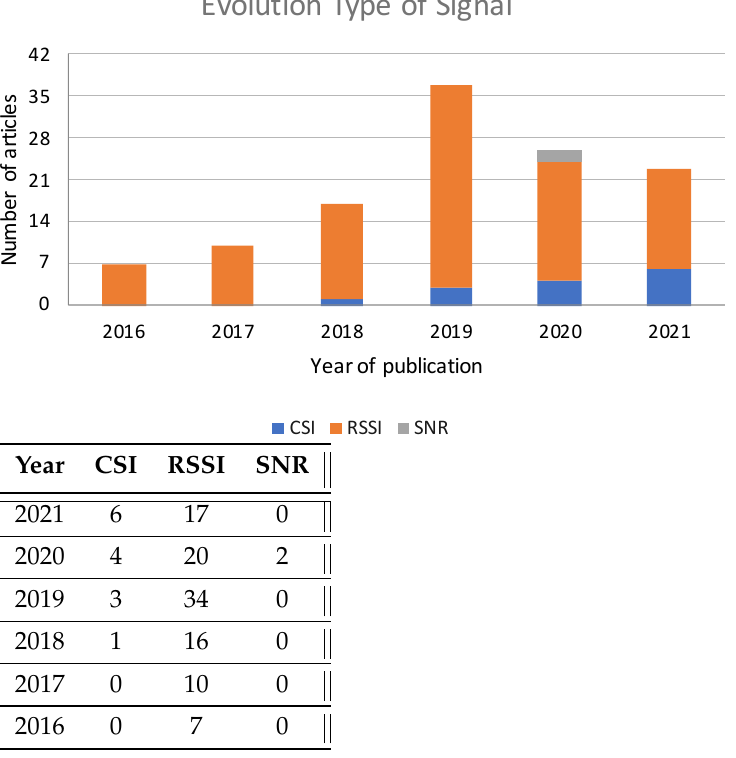
Figure 5. Evolution of the types of signal